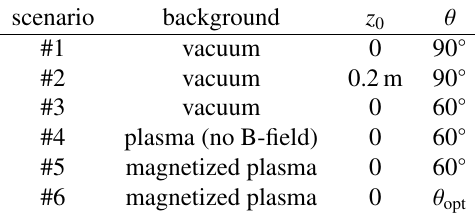
Table 1. Scenario configurations in the toroidal plane, z 0 corresponds to the position of the beam waist, θ refers to the injection angle with respect to the y -axis, where θ opt is the angle resulting in maximum mode conversion e ffi ciency, Eq.